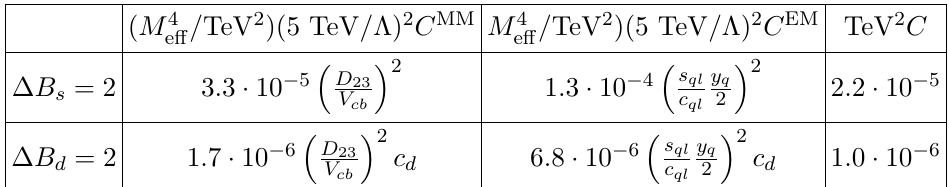
Table 4 . Predictions for the coe(cid:14)cients in the relevant e(cid:11)ective Lagrangians, as de(cid:12)ned in the text, compared with the current bounds in the last column.